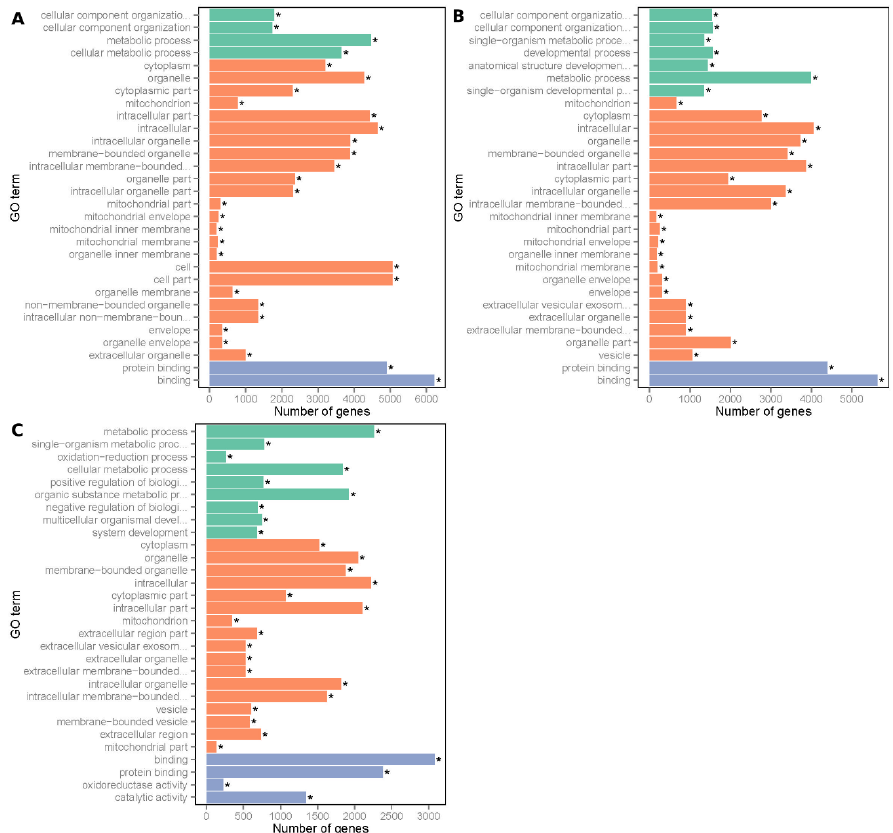
Figure 4. Top 30 of gene ontology (GO)-enrichment for DEGs from three groups of pairwise comparisons. ( A ) Natal pigs vs. E65 pigs; ( B ) adult pigs vs. E65 pigs and ( C ) adult pigs vs. natal pigs. The x -axis presents the number of DEGs in a category. The y -axis shows the specific GO term. The green histogram represents the biologic process, the orange histogram represents cellular component and the purple histogram represents the molecular function. The asterisk (*) indicates a threshold of padj <